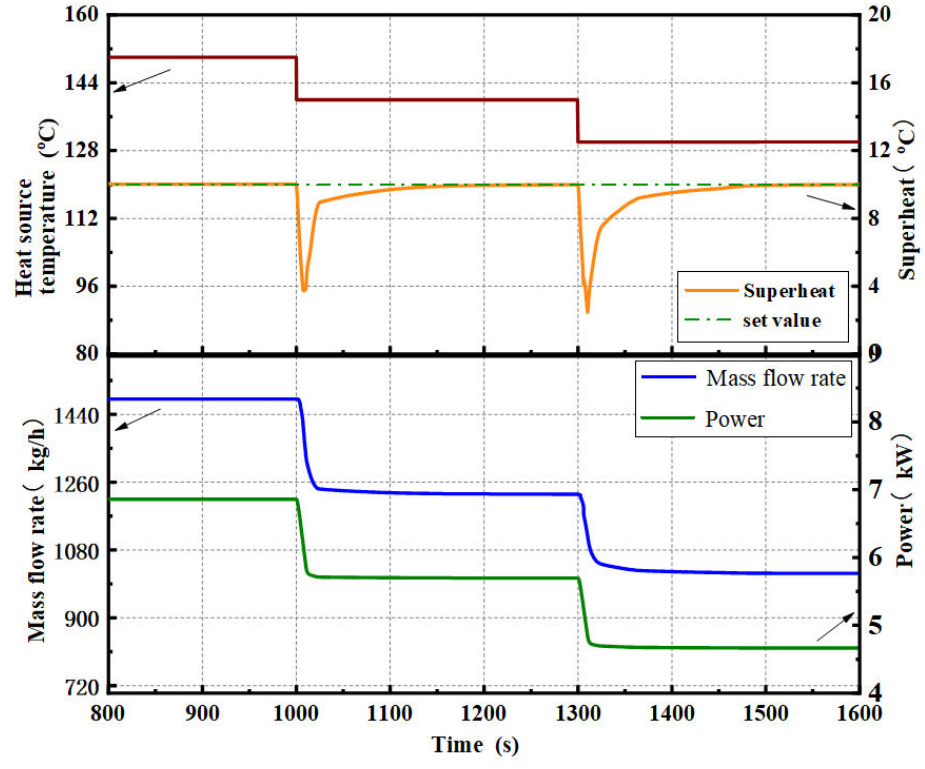
Figure 7. Dynamic response of key operating parameters under the CVS